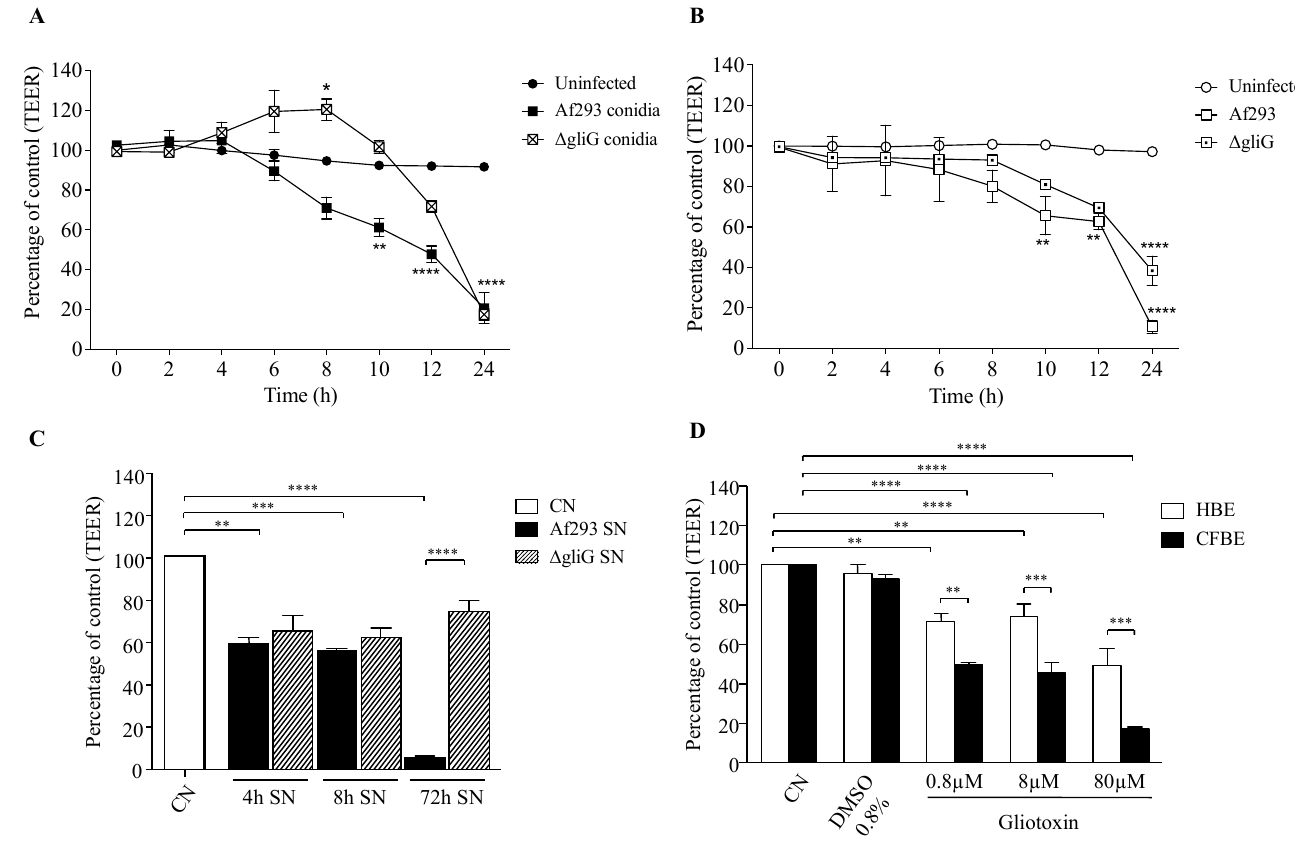
Figure 2. Effect of gliotoxin on the integrity of CFBE and HBE monolayers. ( A ) TEER of CFBE monolayers alone, exposed to Af293 conidia and ∆ gliG conidia. ( B ) TEER of HBE monolayers alone, exposed Af293 conidia and ∆ gliG conidia. ( C ) TEERs of untreated CFBE cells (CN, white bars) and CFBE cells following 24 h exposure to 4, 8 and 72 h supernatants of Af293 and ∆ gliG . ( D ) TEER of CFBE and HBE following 24 h exposure to 0.08% DMSO, 0.8 µ M, 8 µ M and 80 µ M gliotoxin. Error bars represent standard error of at least three independent replicates. * p < 0.05, ** p < 0.01, *** p < 0.001, **** p < 0.0001.